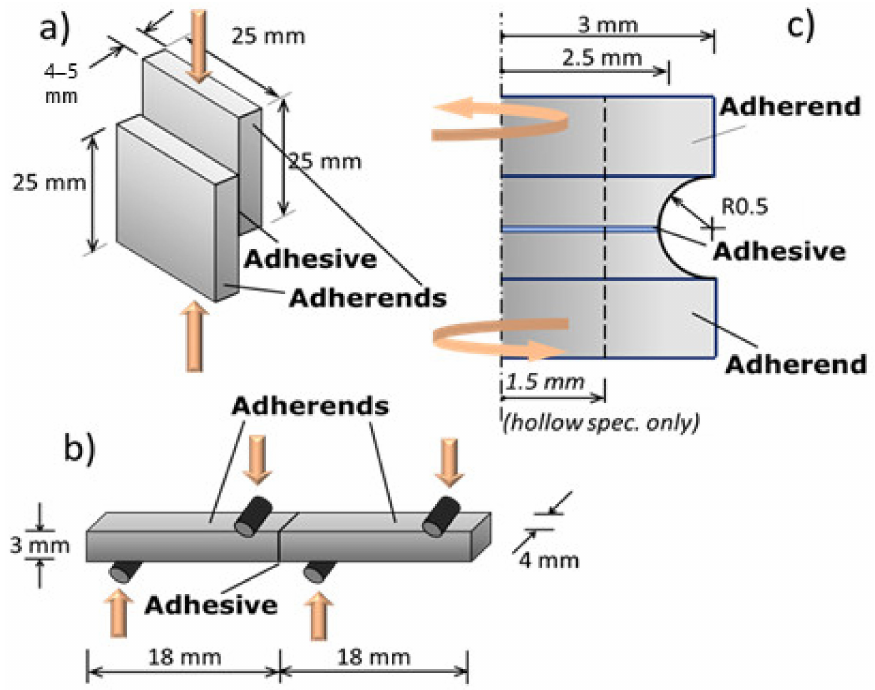
Figure 1. Schematic representation of the three mechanical tests used for the comparison of shear strength measurements on EA9321 joined samples: ( a ) single lap offset (SLO); ( b ) asymmetric 4-point bending (A4PB) ASTM C1469; ( c ); torsion on hourglass-shaped samples with full joined (THG) or an annular joined area (TDHG). All sizes are in